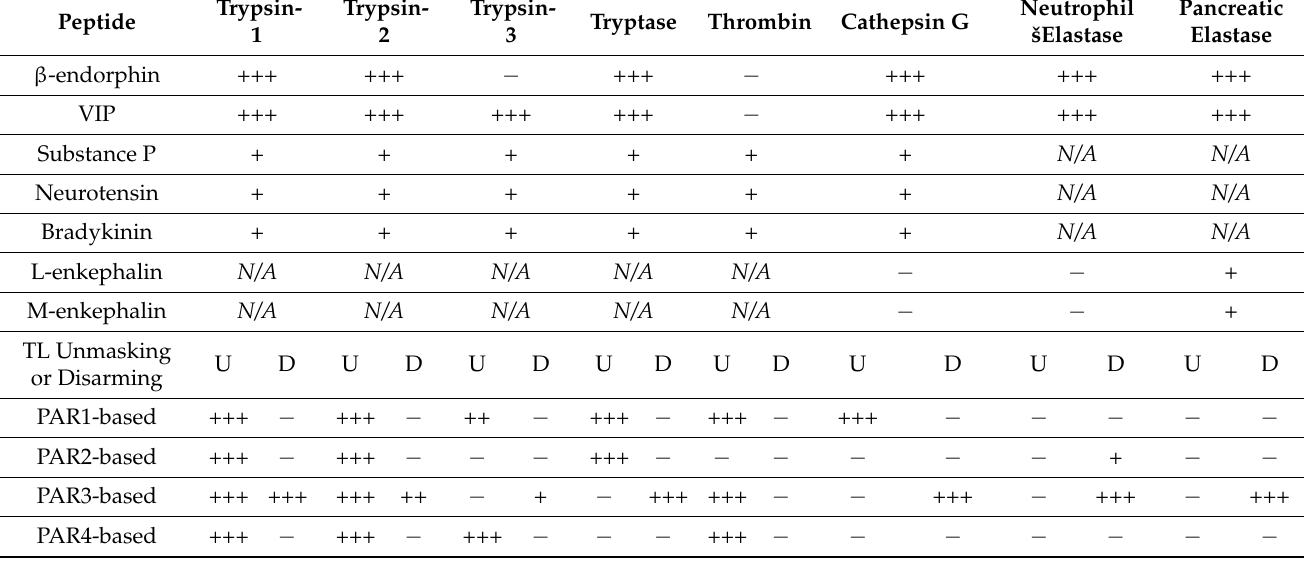
Table 1. Efficiency of a set of proteases (trypsin-1, trypsin-2, trypsin-3, tryptase, thrombin, cathepsin G, neutrophil elastase and pancreatic elastase) to cleave peptides related to pain and inflammation. VIP = Vasoactive intestinal peptide. The ability of the proteases to unmask (U) or disarm (D) the tethered ligand (TL)-sequence of the protease-activated receptor (PAR)-based peptides is shown as well. The efficiency of the first cleavage in the peptide is shown as +++ ultrafast processing within 2 min; ++ fast processing after 5 min; + processing after 10 or 30 min; − no processing, N/A not analyzed.